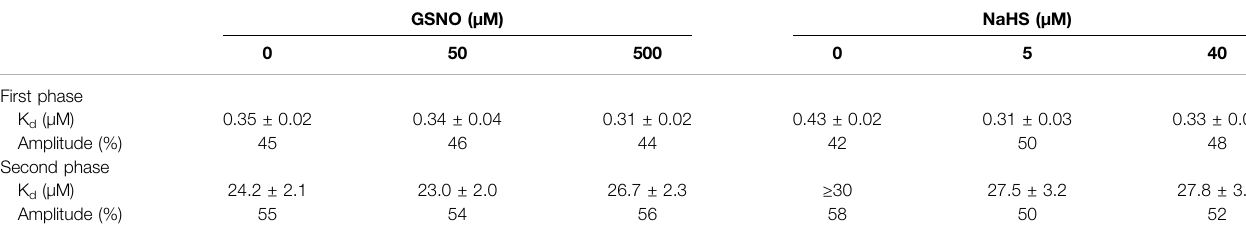
TABLE 3 | Effect of nitrosylation or sulfhydration on the FAD-apoprotein hDAAO complex. The cofactor dissociation constants (K d ) determined by measuring the protein fl